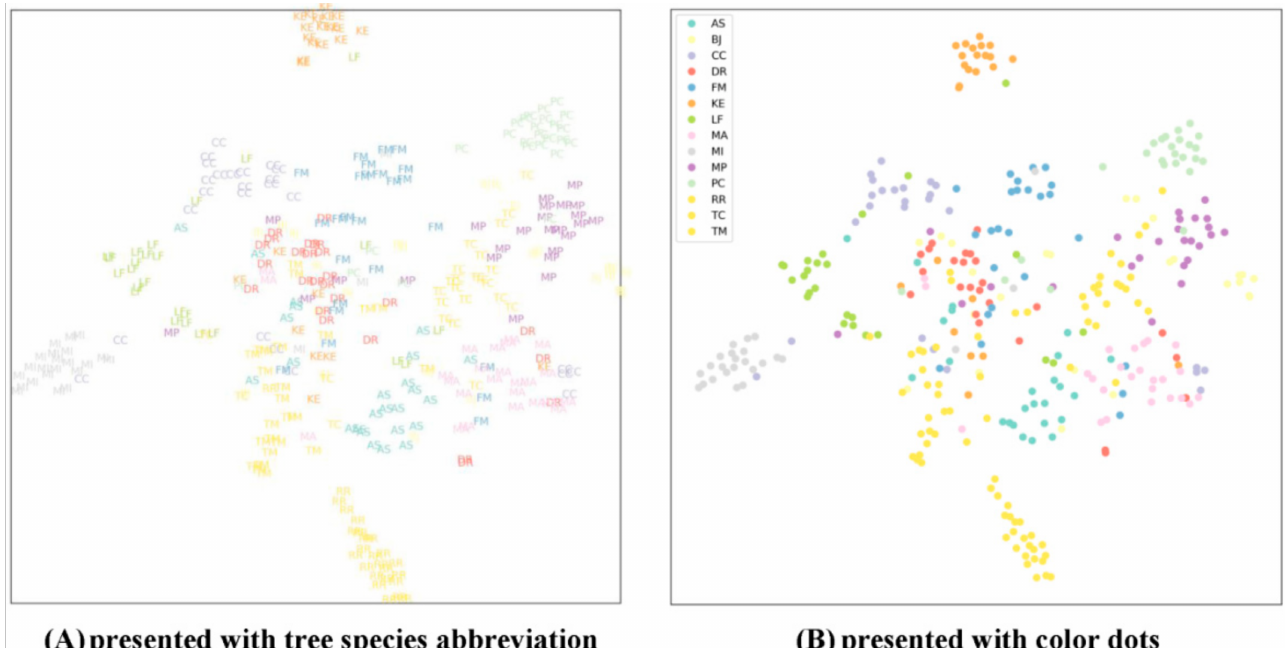
Figure 7. Two-dimensional T-distributed Stochastic Neighbor Embedding (T-SNE) visualization in each class of the 14 tree species is presented with tree species abbreviation ( A ) and with color dots ( B ). Alstonia scholaris (AS), Bischofia javanica (BJ), Cinnamomum camphora (CC), Delonix regia (DR), Ficus microcarpa (FM), Koelreuteria henryi (KE), Liquidambar formosana (LF), Melia azedarach (MA), Melaleuca leucadendra (MI), Millettia pinnata (MP), Cassia fistula (PC), Roystonea regia (RR), Terminalia catappa (TC), and Terminalia mantaly